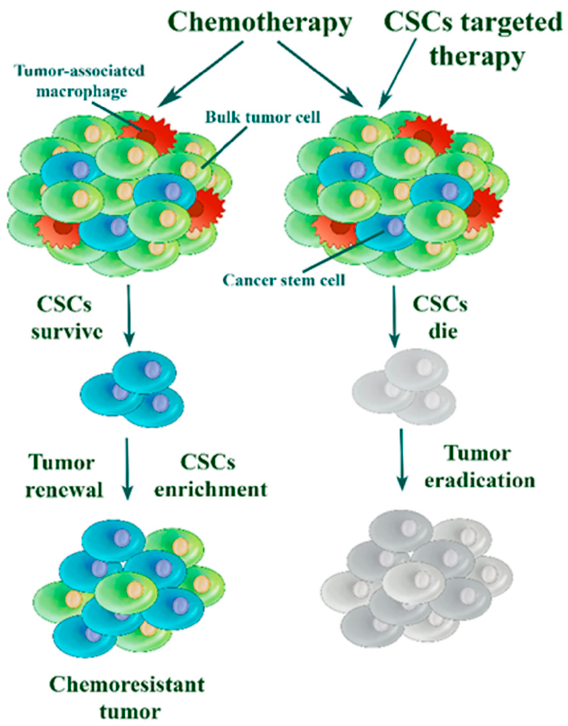
Figure 1. Cancer stem cell theory. Chemotherapy reduces bulk tumor burden but resistant cancer stem cells (CSCs) survive and are able to drive tumor recurrence. Specifically targeting CSCs is necessary to achieve stable tumor remission.